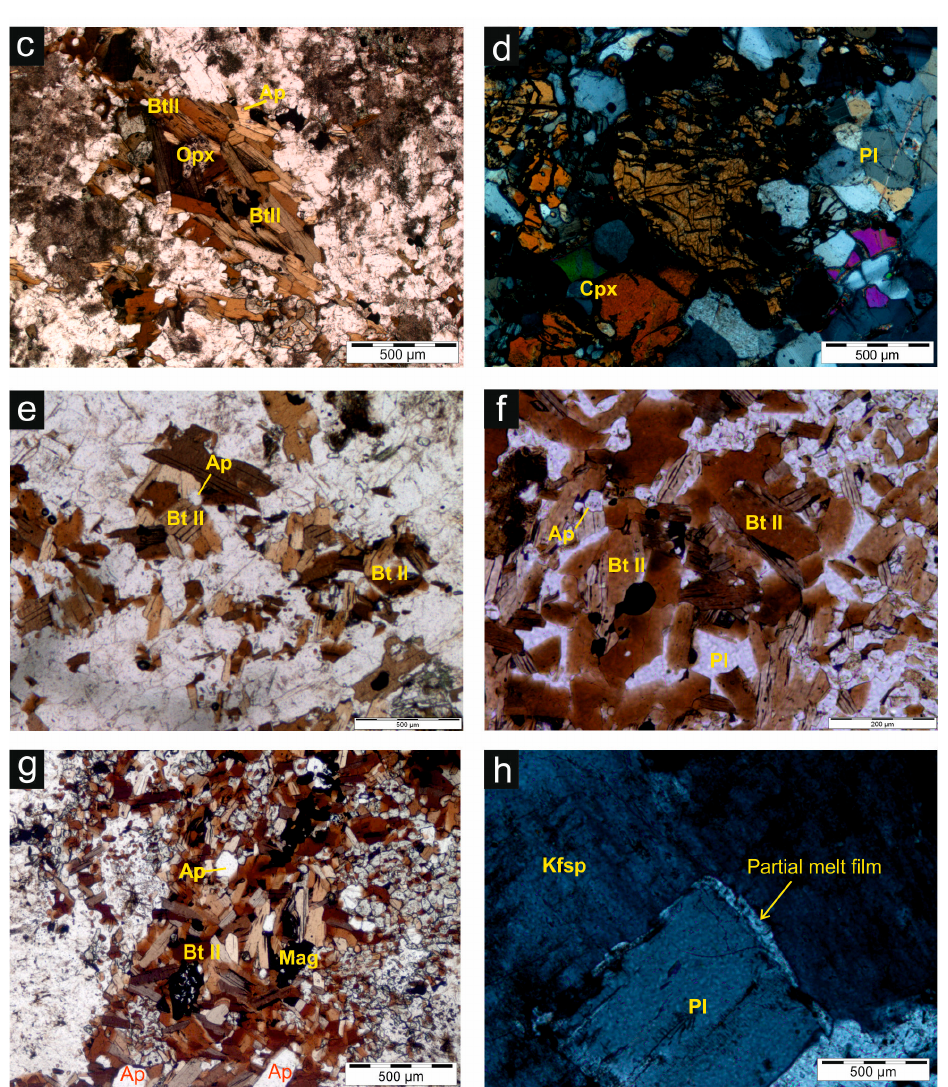
Figure 3. Texture of the unmineralized charnockite in the NM-57 drill core (Dunka Pit deposit). ( a , b ) Residual biotie I (Bt I) replaced by orthopyroxene (opx) (PPL image). ( c ) Orthopyroxene replaced by subhedral-euhedral biotite (Bt II) (PPL image). ( d ) Euhedral ortho-and clinopyroxene, 5 m from the contact (XPL image). ( e – g ) Euhedral biotite II (Bt II) intergrown with euhedral apatite (Ap). ( h ) Partial melt film between feldspars (XPL image).